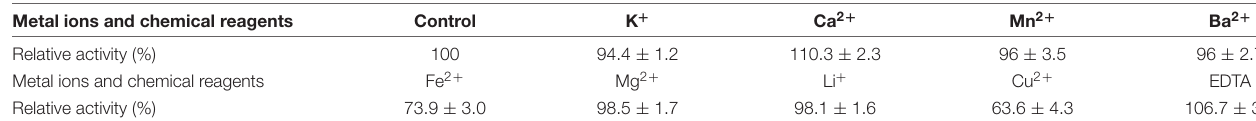
TABLE 2 | Effects of metal ions and chemical reagents on CGTase activity.